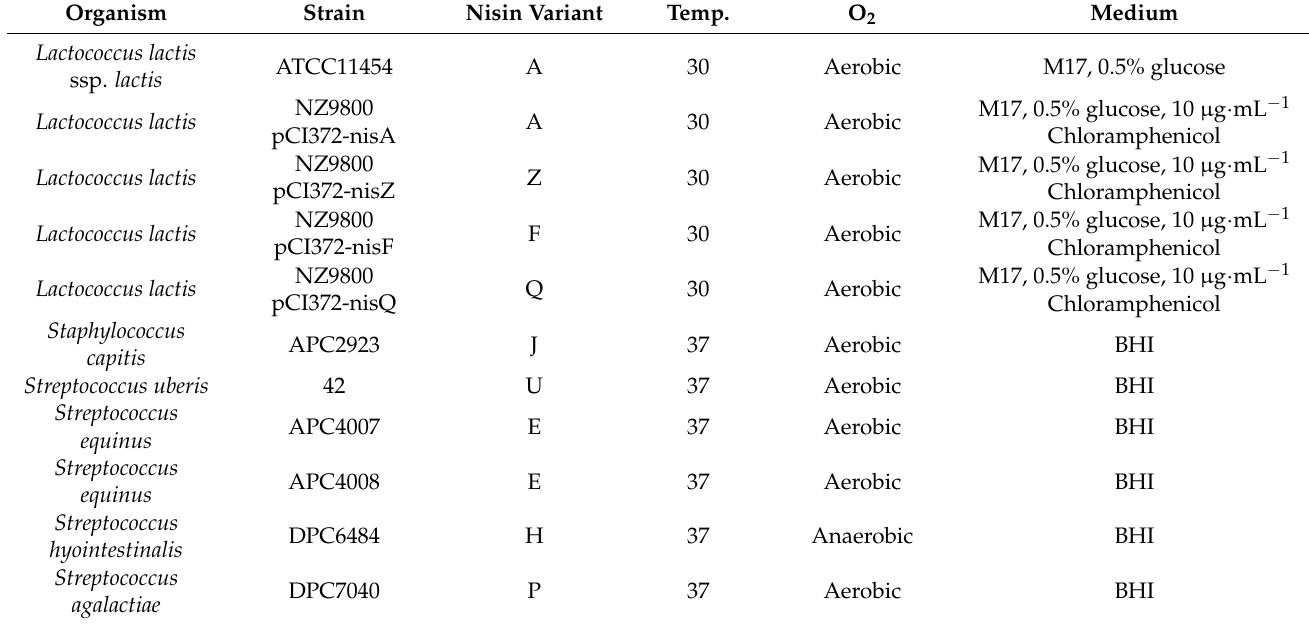
Table 1. Nisin-producing strains used in this study and their growth